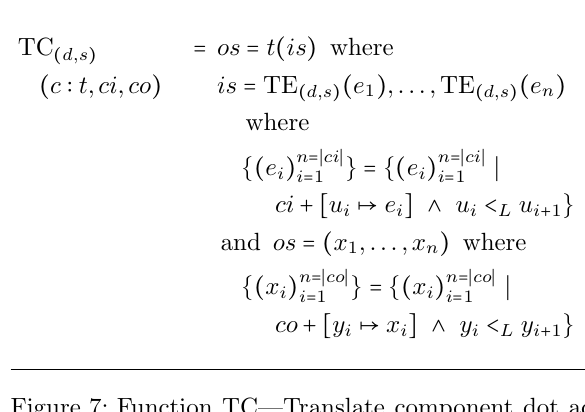
Figure 7: Function TC—Translate component dot ac- cesses to an SDFK equation with an RHS SDFK node